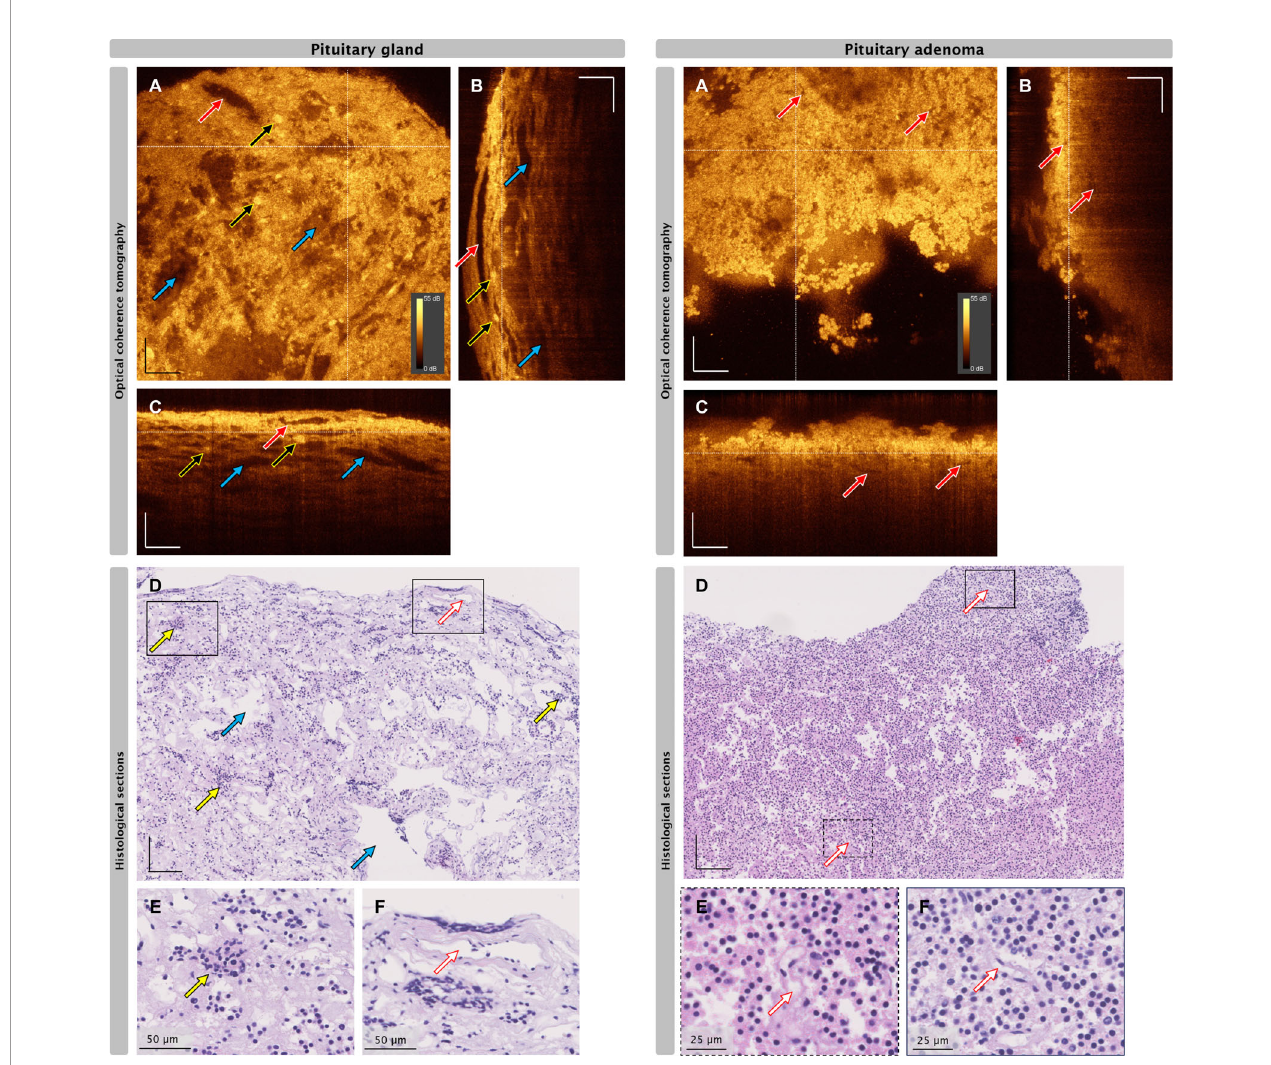
FIGURE 1 | Correlation of OCT and histopathological images of pituitary gland tissue (left) and pituitary adenoma (right). (A) Enface OCT projections, white dotted lines indicate positions of cross-sectional OCT (B-scan) positions. (B, C) B-scans at the indicated positions depicted in A. (D – F) H&E slices of the same biopsy. Red arrows: blood vessel, yellow arrows: representative nests, blue arrows: mechanical or freezing artifacts. Scale bars without label: 100 µm. Dynamic range 0-55 dB applicable for each OCT